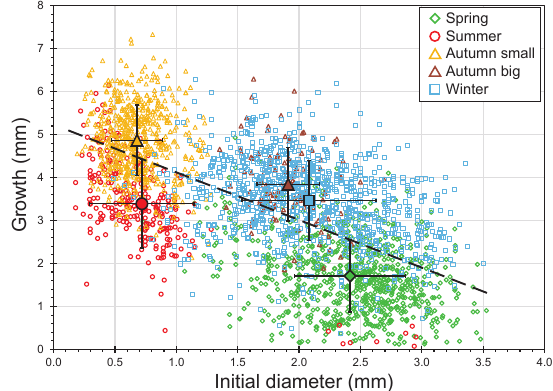
Figure 12. Length of new tube growth during the experiments plot- ted against initial diameters of all measured worm tubes. The dashed line is a linear fit to the data ( R 2 = 0 . 41, n = 2783, p = 0). Data are from all experiments and treatments. Small symbols indicate in- dividual S. spirorbis specimens, while the larger symbols show the seasonal mean values ( ± 1SD). Autumn-small and autumn-big pop- ulations are plotted